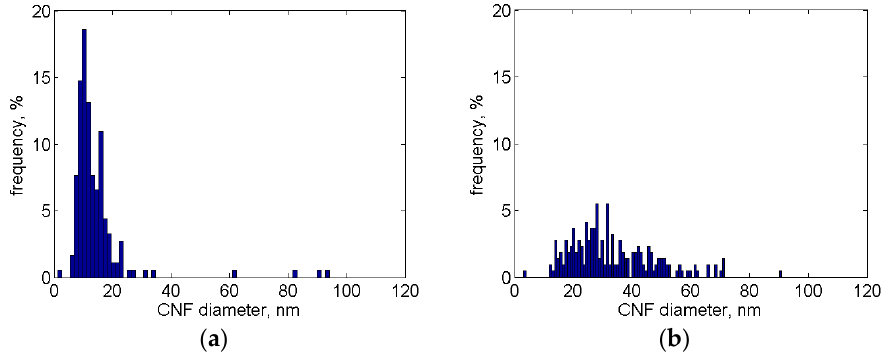
Figure 8. Distributions of CNF diameters after about 5 wt % ( a ) or 16 wt % ( b ) growth, after acetone solution.